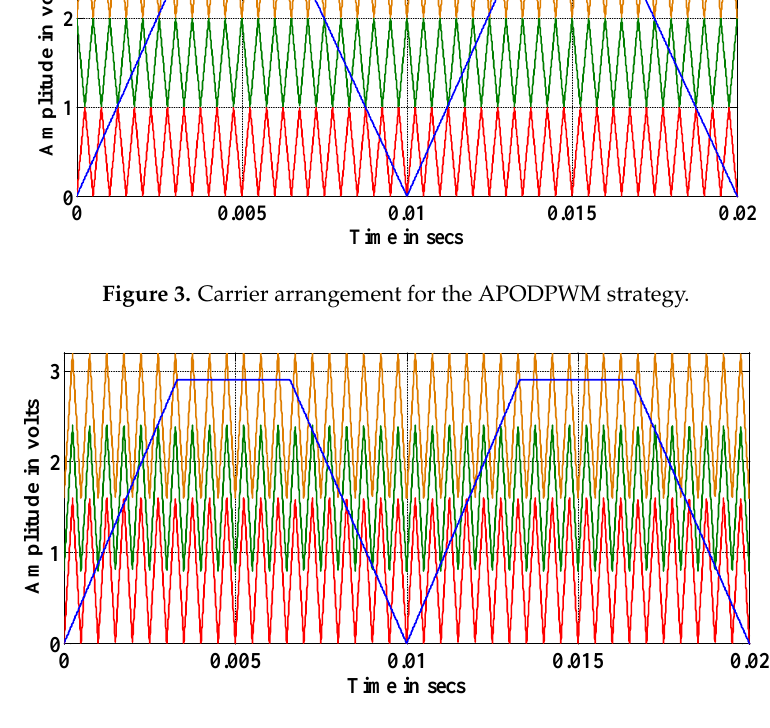
Figure 4. Carrier arrangement for the COPWM strategy.